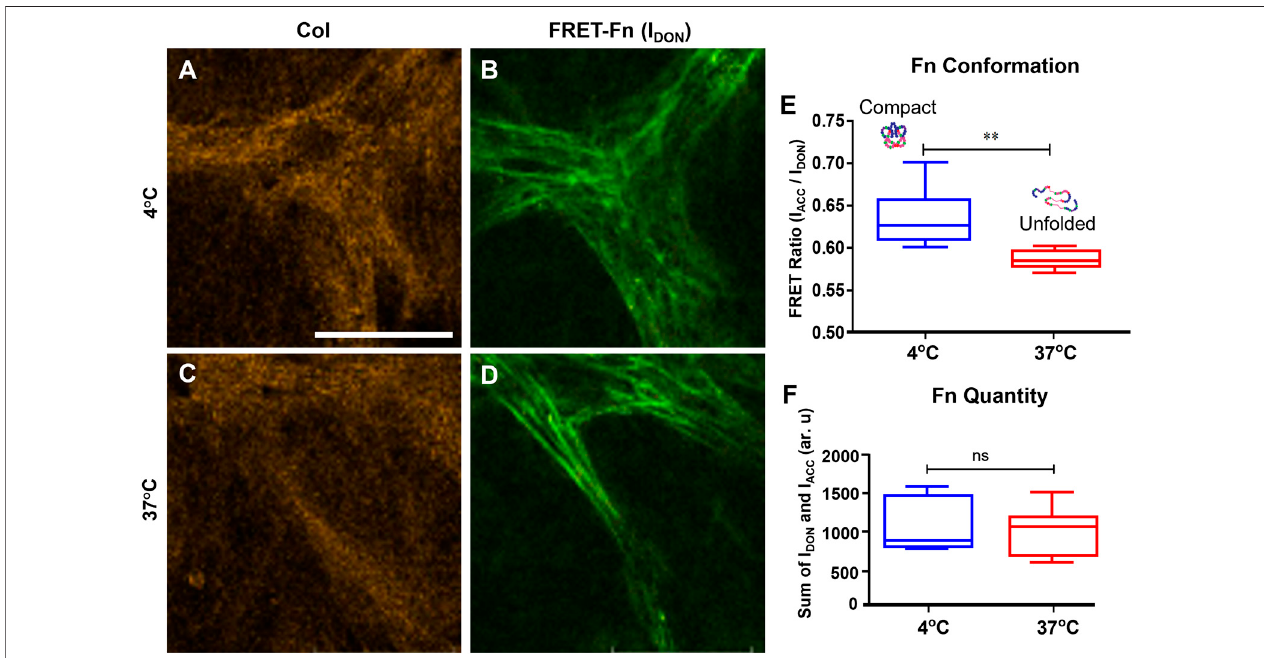
FIGURE 5 | Fibronectin coating dictates the conformation of the new matrix deposited by 3T3-L1s after 48 h incubation. Confocal re fl ectance microscopy (CRM) image of Col (A) and fl uorescence image (donor channel) of FRET-labeled cell-deposited Fn fi bers (B) of same fi eld of view of a scaffold coated at 4 ° C. Same imaging method/channels for a scaffold coated at 37 ° C (C,D) . Mean FRET ratios (I ACC /I DON ) highlighting the signi fi cant difference between Fn fi bers formed on the 4 ° C scaffold (0.64±0.03)comprisingmorecompactFnconformationsthanFn fi bersonthe37 ° Cscaffold(0.59±0.02)inwhichunfoldedFnconformationsarealsopresent (E) . Total quantity of Fn (I ACC + I DON ) detected onto both scaffolds indicating similar Fn amount/density between 4 and 37 ° C conditions (F) . *** p < .001, Student ’ s t-test, Mean ± SD. Scale bar = 30 μ m.